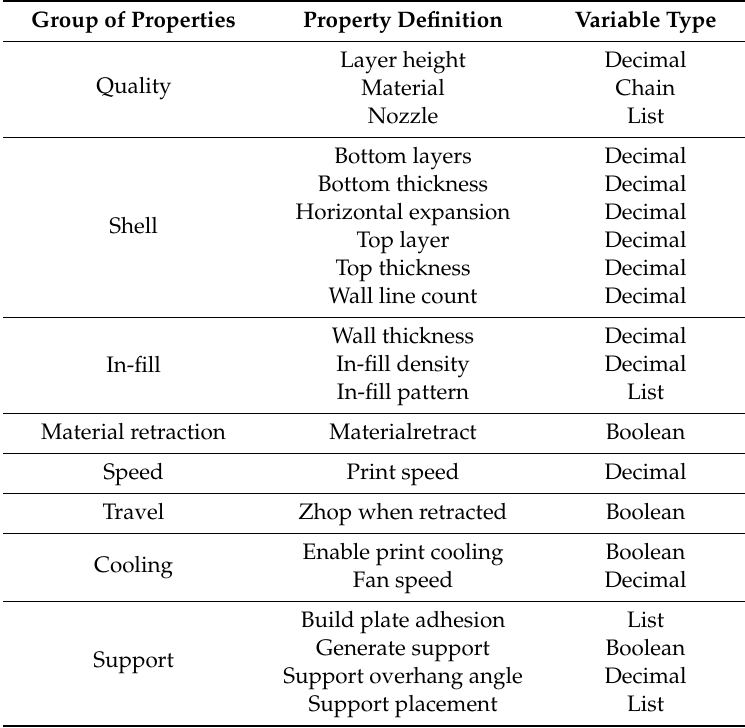
Table 11. Properties and technological characteristics used in the definition of the group associated with the manufacture of the BIM, the E 1 and E 2 construction